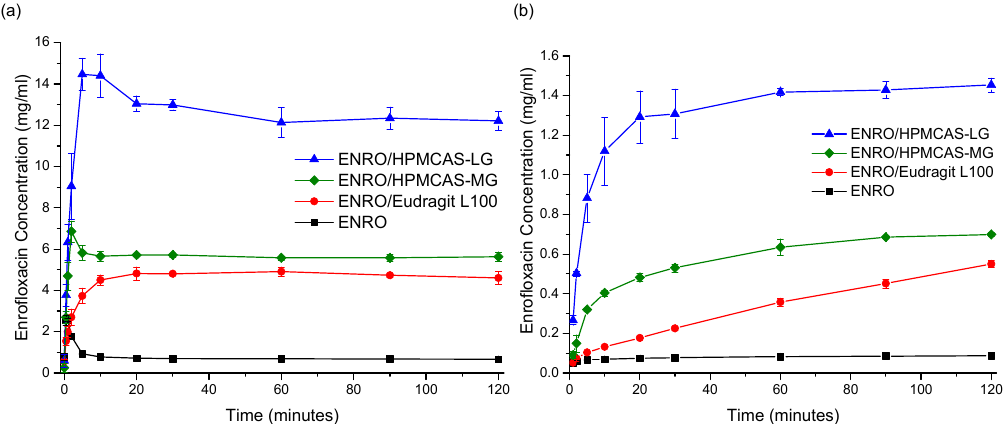
Figure 8. ( a ) Solubility and ( b ) dissolution studies in FaSSIF at 37 °C. The average of three experiments is plotted, ± the standard deviation.